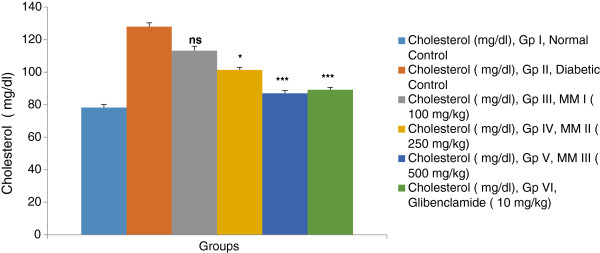
Effect of Melastoma malabathricum Linn. (MM) on level of total cholesterol at different concentrations on STZ induced diabetic rats, compared to standard drug Glibenclamide; values are mean ± SEM; n = 6; *P < 0.05; **P < 0.01; ***P < 0.001; P > 0.05 is considered as non-significant (ns).